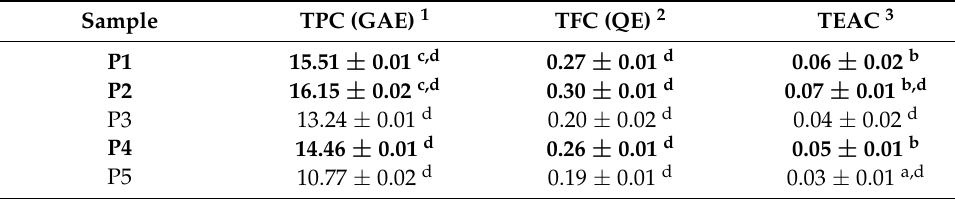
Table 3. Total phenol content, total flavonoid content, and antioxidant